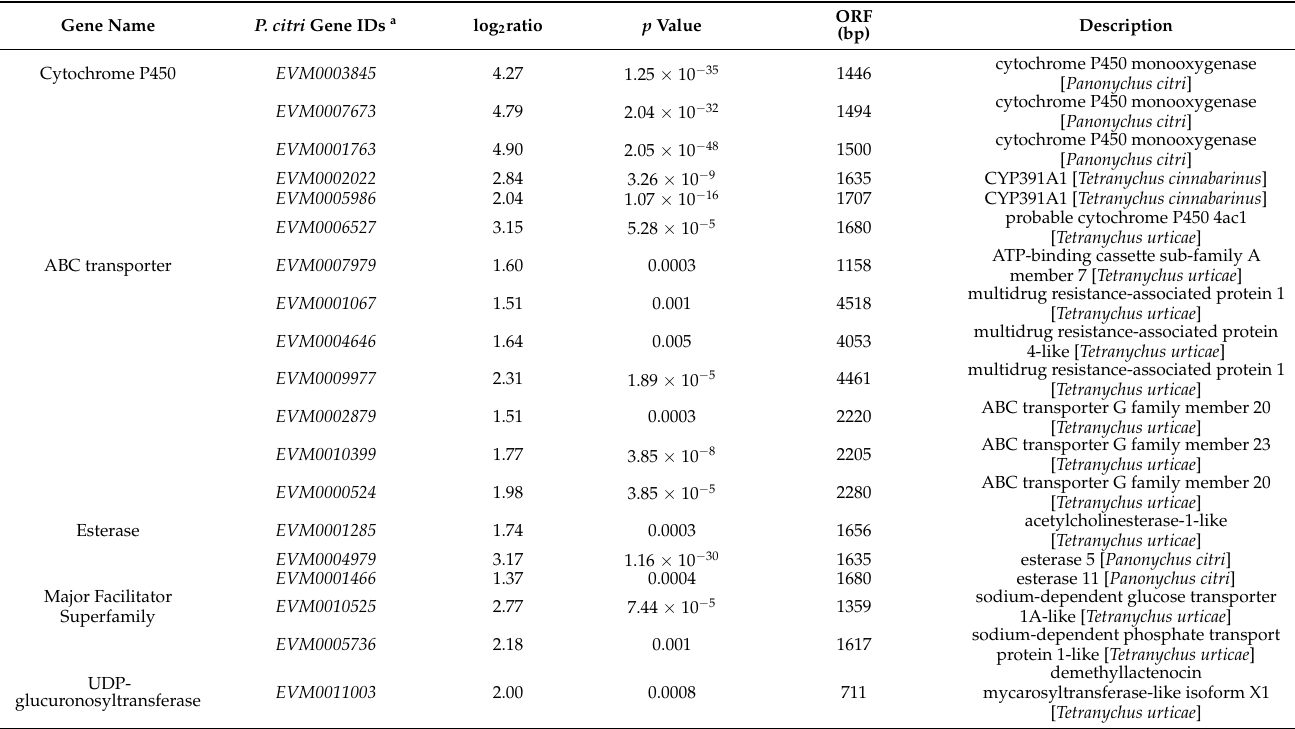
Figure 2. Top 20 KEGG classification of differentially expressed genes. The abscissa values mean the number of genes annotated to the pathway and their proportion to the total number of genes annotated, and the ordinate represents the different KEGG classifications. The q value is defined by the ratio of the differentially expressed genes enriched in the pathway and the number of all genes enriched in the same pathway ( p < 0.05). Table 4. Summary of DEGs